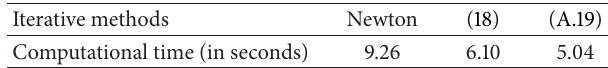
Table 2: Comparison of different optimal methods for finding all the zeros of g[x ]